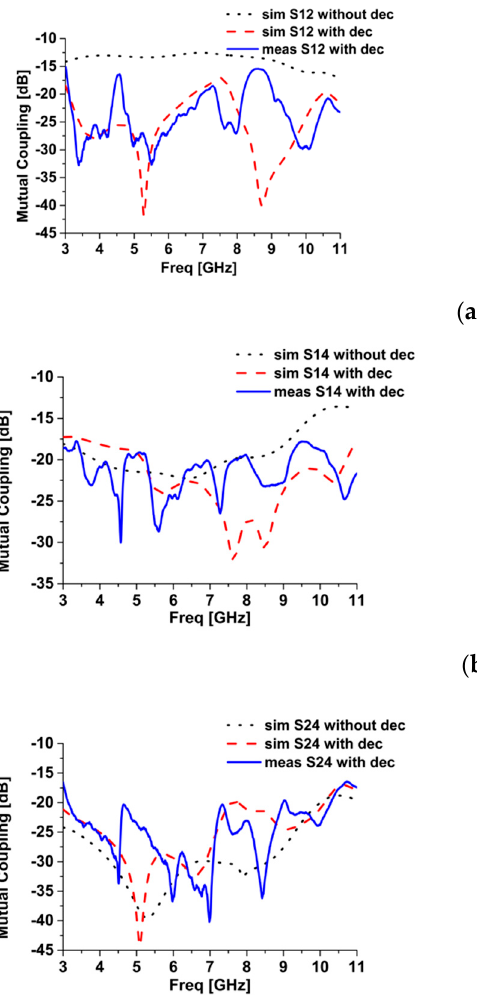
Figure 6. Simulated and Measured reflection coefficient ( a ) antenna 1 and 2; ( b ) antenna 1 and 3.